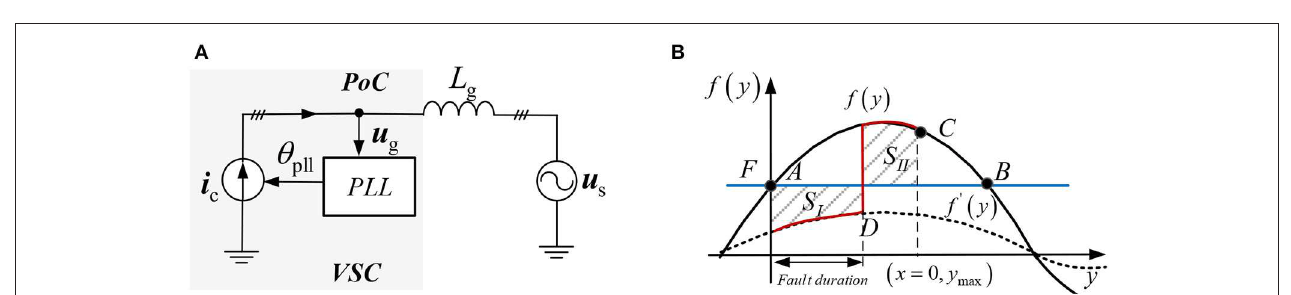
FIGURE 2 | (A) Simplified circuit model for GSS analysis. (B) Mechanism illustration of the